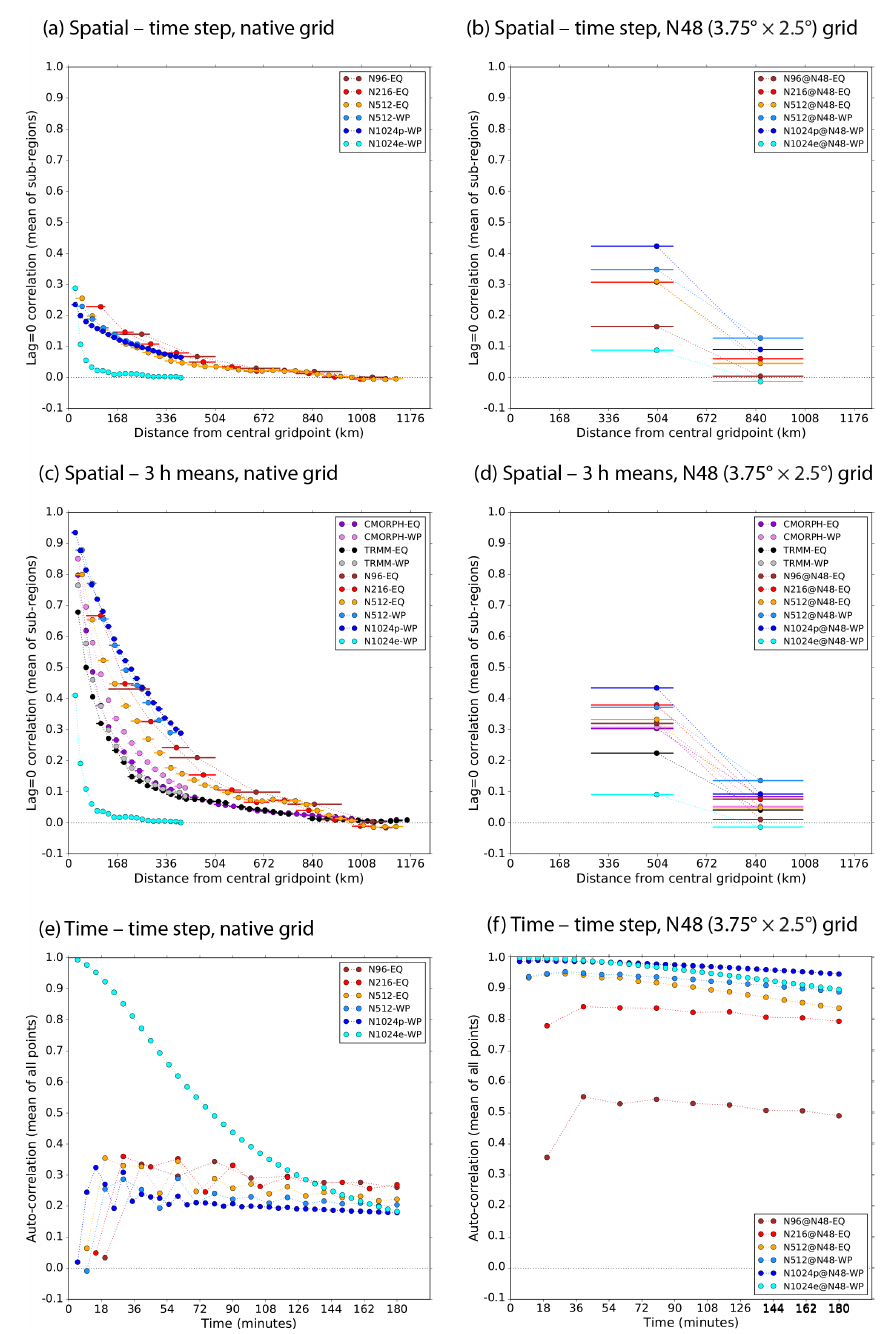
Figure 7. (a–d) A measure of the spatial scale of precipitation, computed by dividing the domain into equal-area regions and calculating the lag-0 correlations between the central grid box and grid boxes within each distance bin (which are (cid:49)x wide, starting from 0 . 5 (cid:49)x) away from the central grid box, then averaging correlations over all regions in the domain, using (a) time step rain rates on the model configurations’ native horizontal grids, (b) time step rain rates averaged to the N48 horizontal grid, (c) 3-hourly rain rates on the native horizontal grid and (d) 3-hourly rain rates on the N48 horizontal grid; (e, f) a measure of the temporal scale of precipitation, computed as the auto-correlation of precipitation, averaged over all boxes in the domain, using (e) time step rain rates on the models’ native horizontal grids and (f) time step rain rates on the N48 horizontal grid. The horizontal lines in (a–d) show the range of distances spanned by each distance bin; the filled circle is placed at the median distance. For clarity, we omit the correlations for zero distance and zero lag, which are 1.0 by definition. In the legends, “-EQ” refers to the EQ analysis domain and “-WP” to the WP analysis domain; “@N48” refers to data averaged to the N48 horizontal